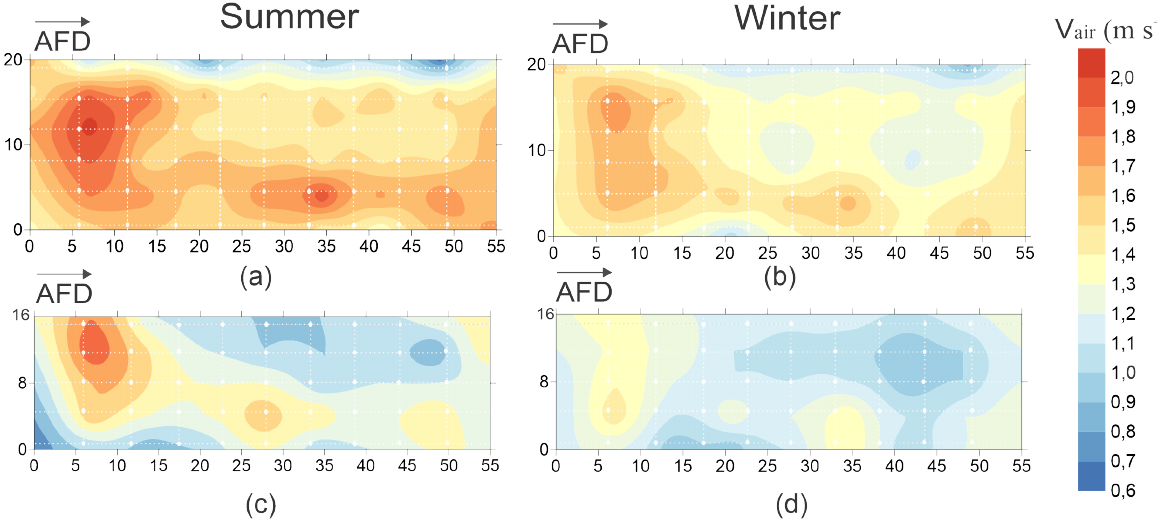
Figure 9. Spatial distribution of variables: a) mean air velocity during the summer (Vm); b) mean air velocity during winter (Vm); c) air velocity at bed level during the summer (Vl); d) air velocity at bed level during winter (Vl), inside the compost bedded pack barn